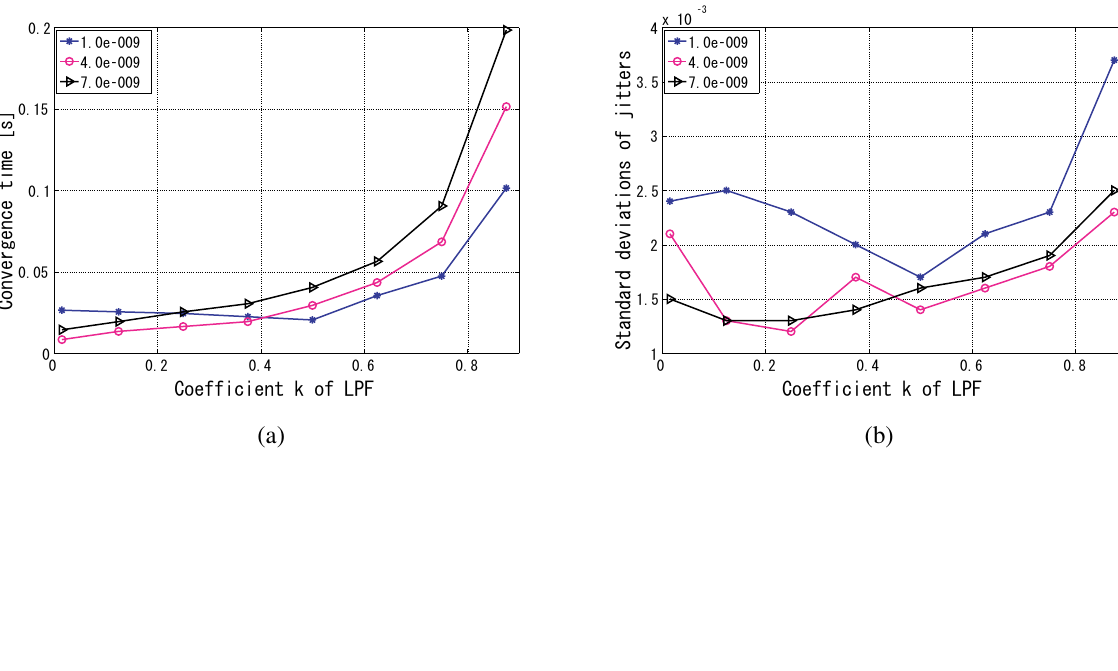
Figure 13. Undershoot phenomena of different coefficient k of LPF when G = 1 . 0 × 10 − 9 , (a) k = 0.0156, (b) k = 0.0125, (c) k = 0.2500, (d) k = 0.3750, (e) k = 0.5000, (f) k = 0.6250, (g) k = 0.7500, (h) k =